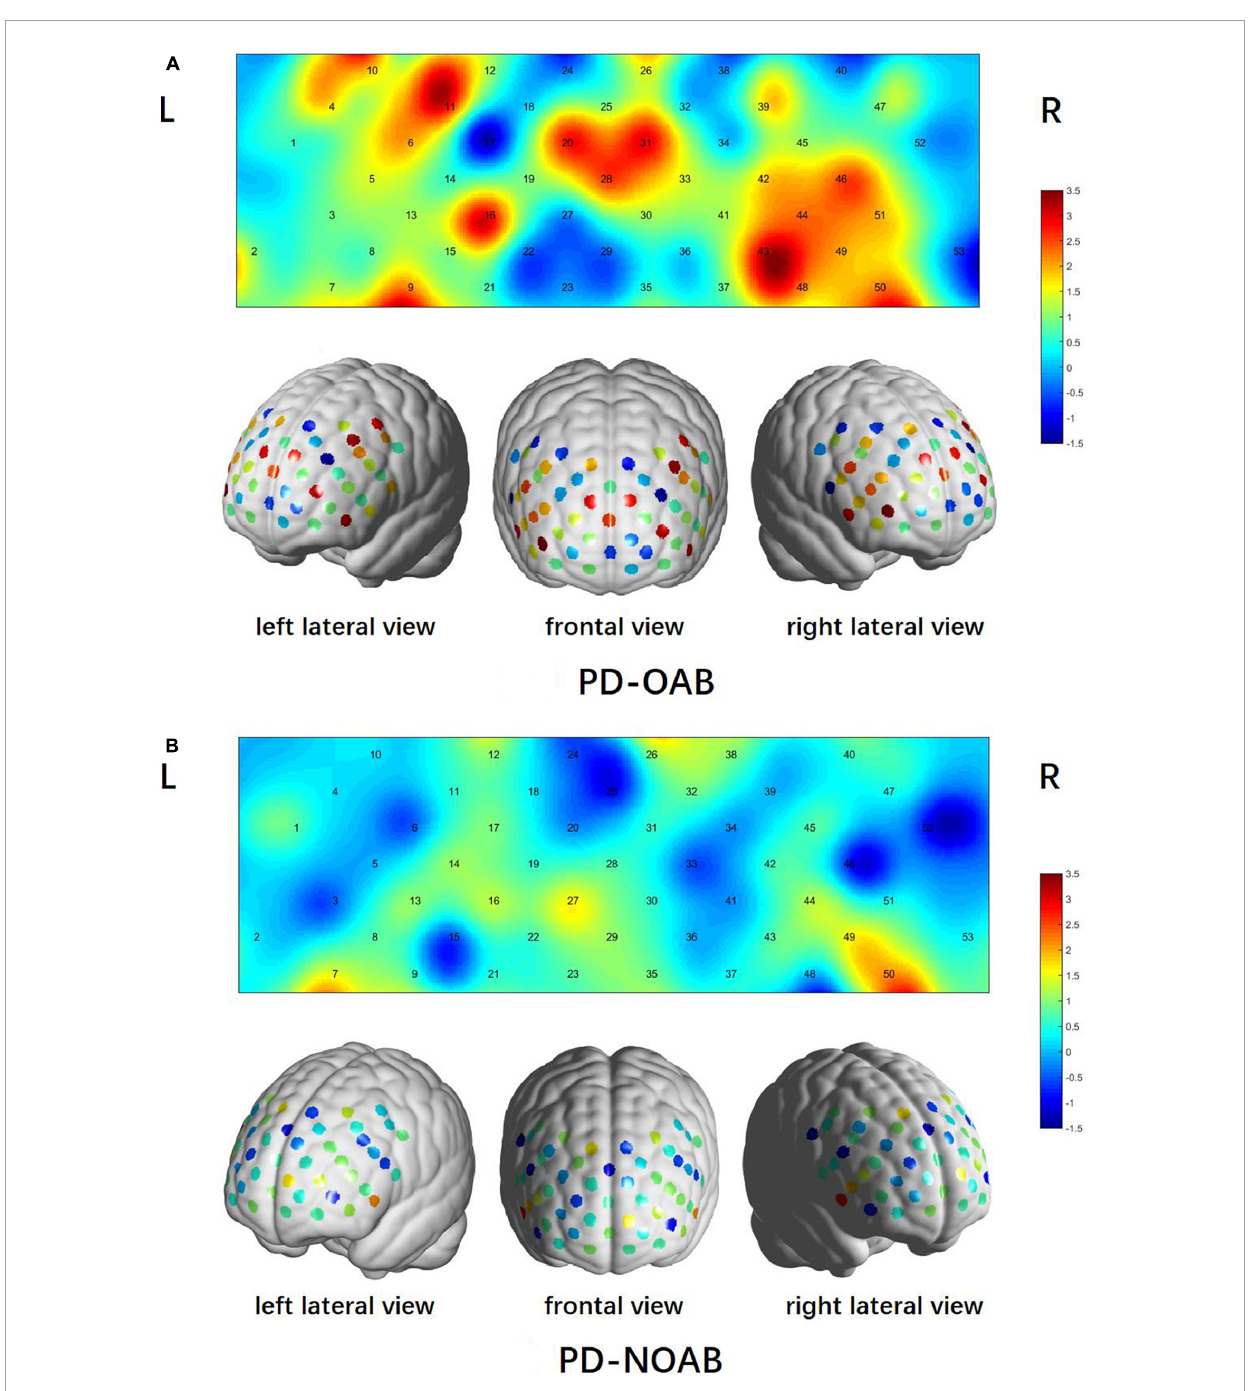
FIGURE2 Patterns of cortical activations during VFT of PD-OAB (A) and PD-NOAB (B)